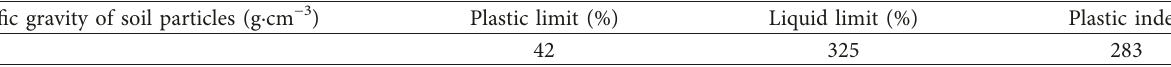
Table 2: Index of physical properties of GMZ001 bentonite.